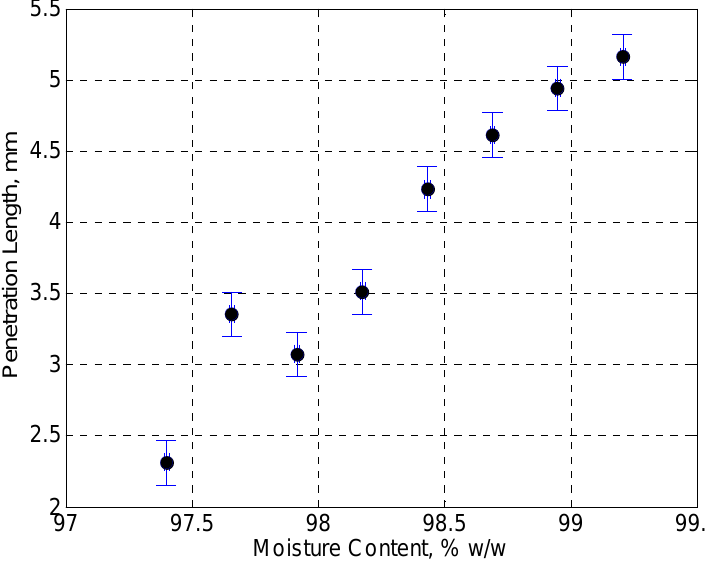
Figure 4. The penetration length of jelly into the pie crust at a temperature of 70 °C plotted as a function of the moisture